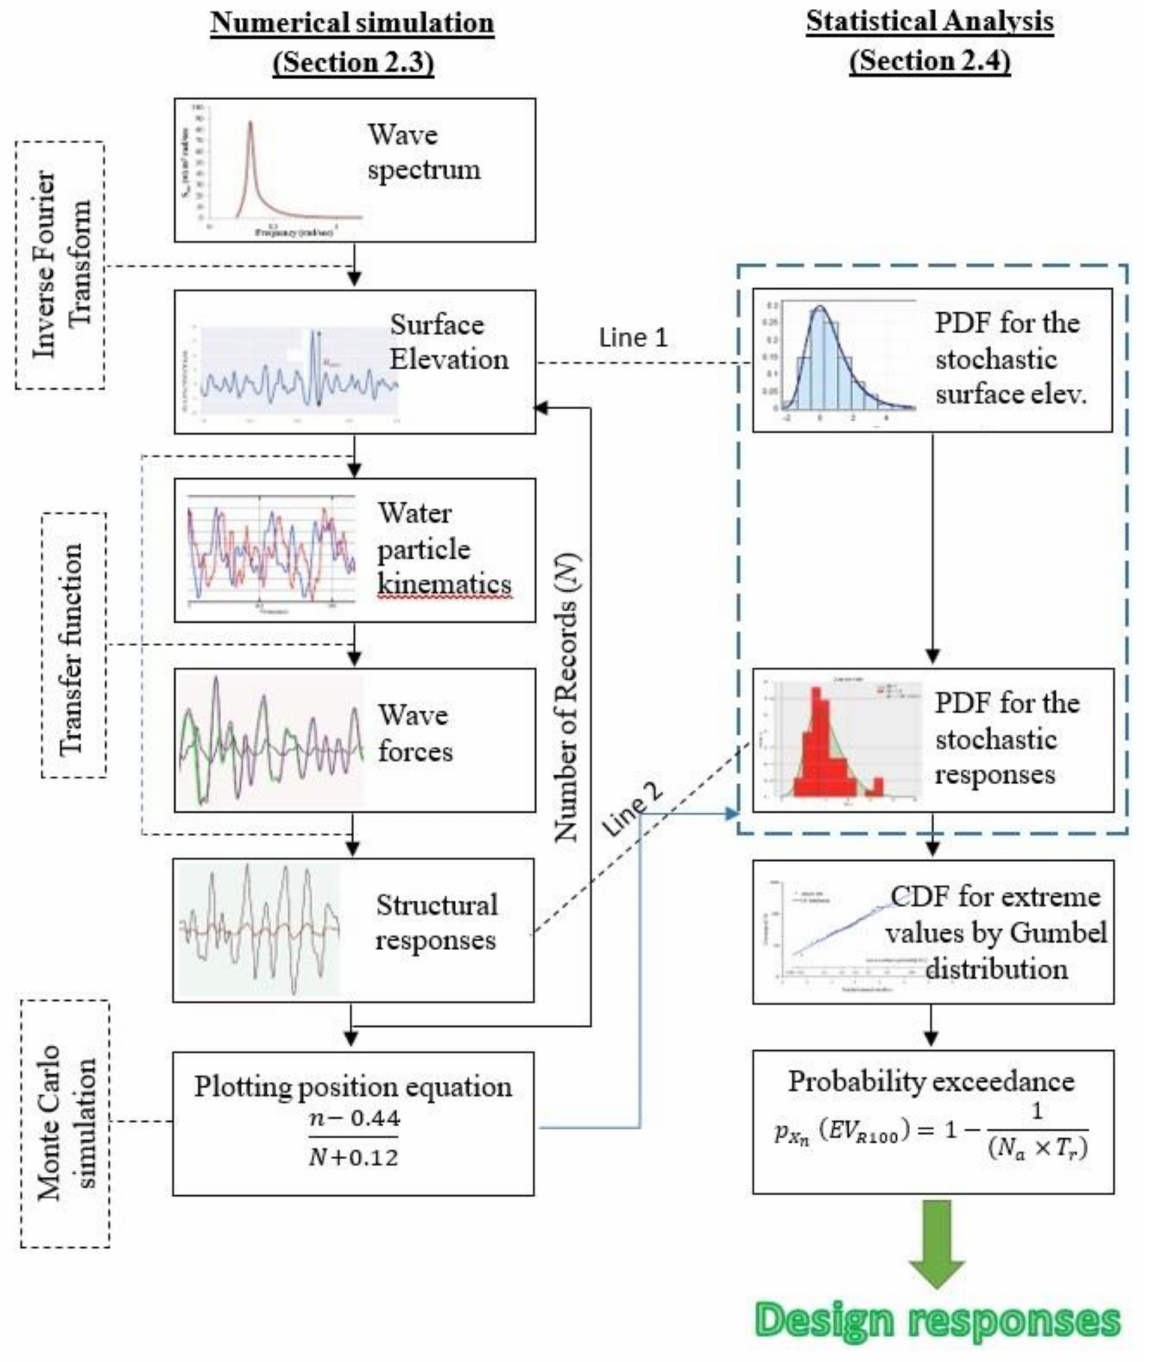
Figure 4. The numerical procedure and its statistical analysis of the structural response design based on the conventional methods in determining return